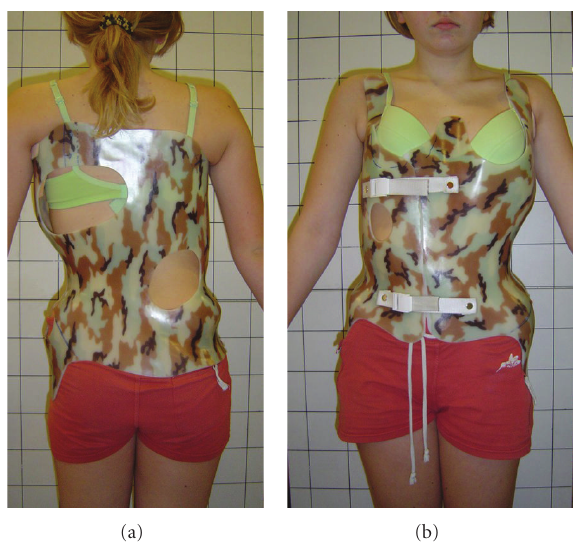
Figure 1: Anterior and posterior view of a patient wearing the Chˆeneau brace.